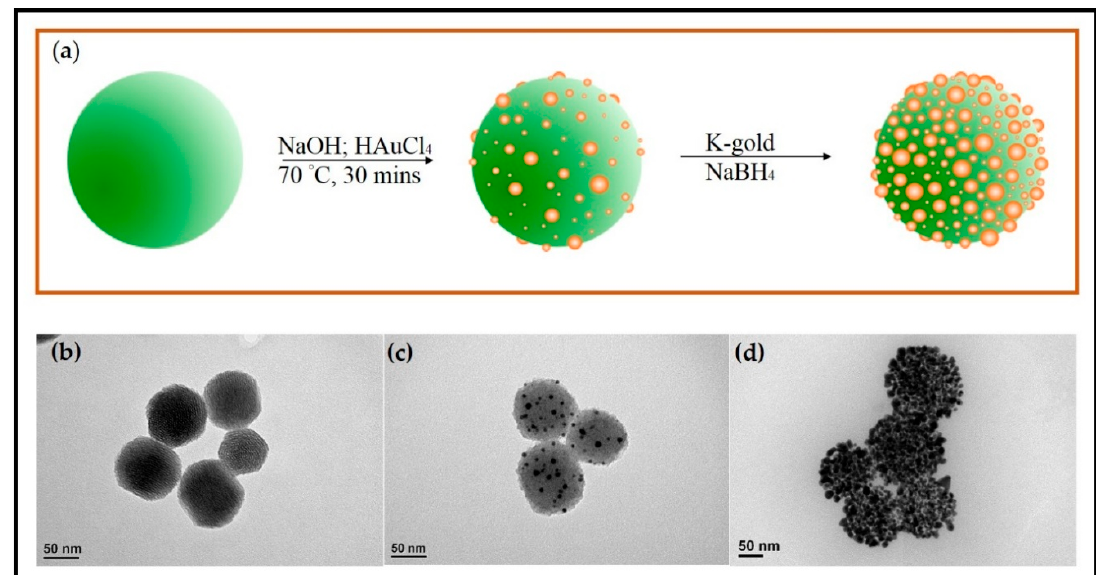
Figure 2. ( a ) Schematic illustration the synthetic route of pollen-structured gold clusters (PSGCs). TEM images of ( b ) mesoporous silica nanoparticle (MSN)-NH 2 , ( c ) seed particles, and ( d ) PSGCs .